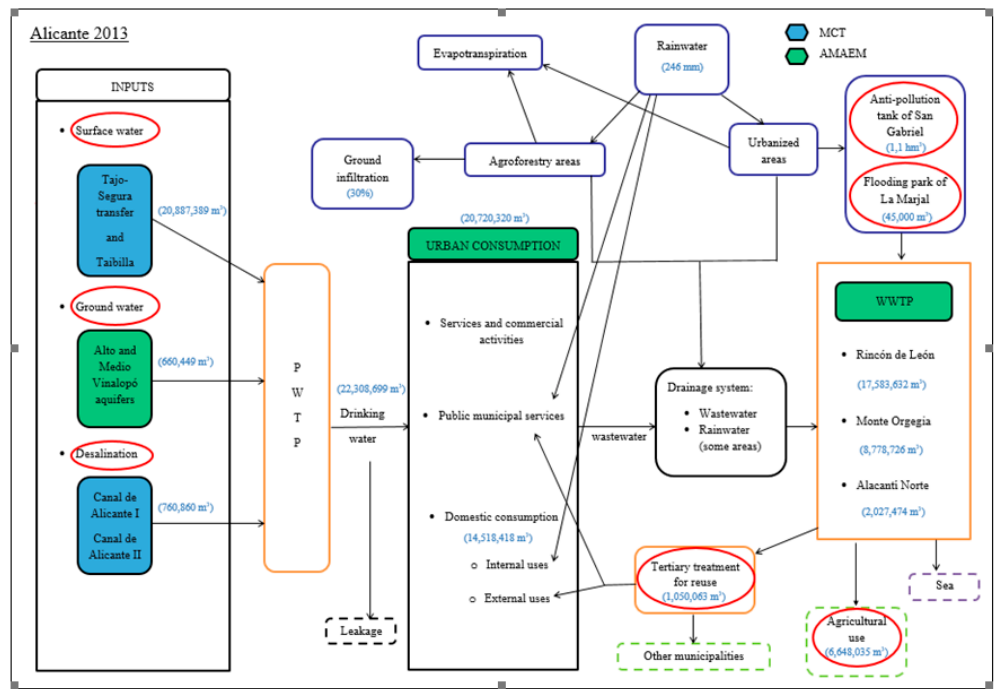
Figure 3. Flow diagram of the city of Alicante in 2013. Compiled by the author.